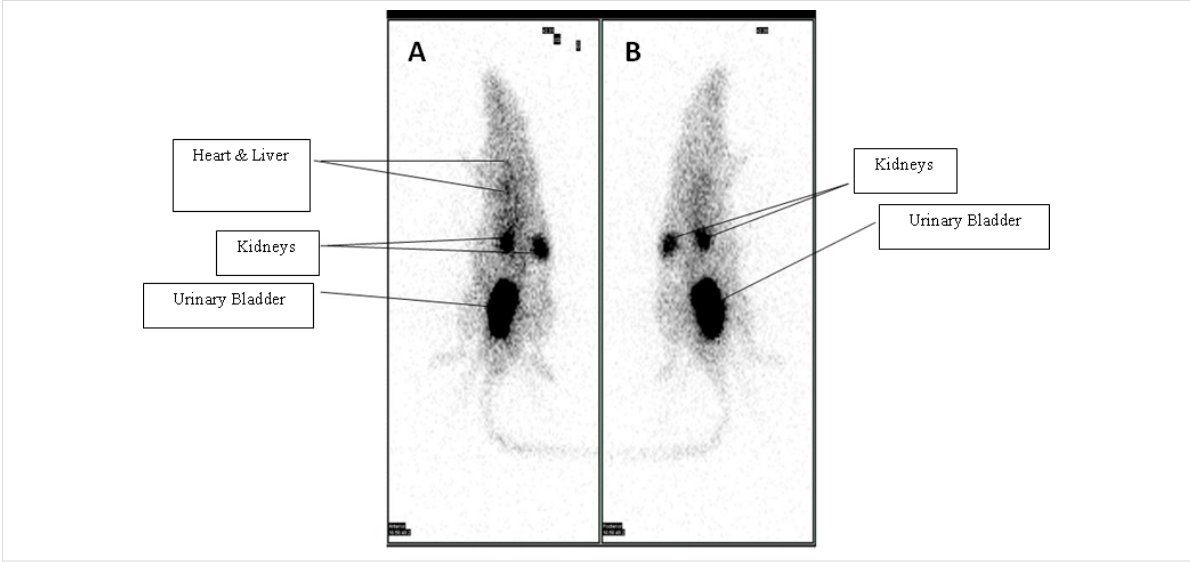
Figure 5: Gamma scintigraphic image of the biodistribution of Tc-99m–Gd 2 O 3 nanoparticles in a rat showing a dorsal (A) and a ventral (B) view.